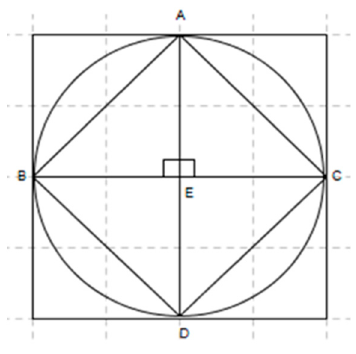
Figure 6. The sixth ornamentation.